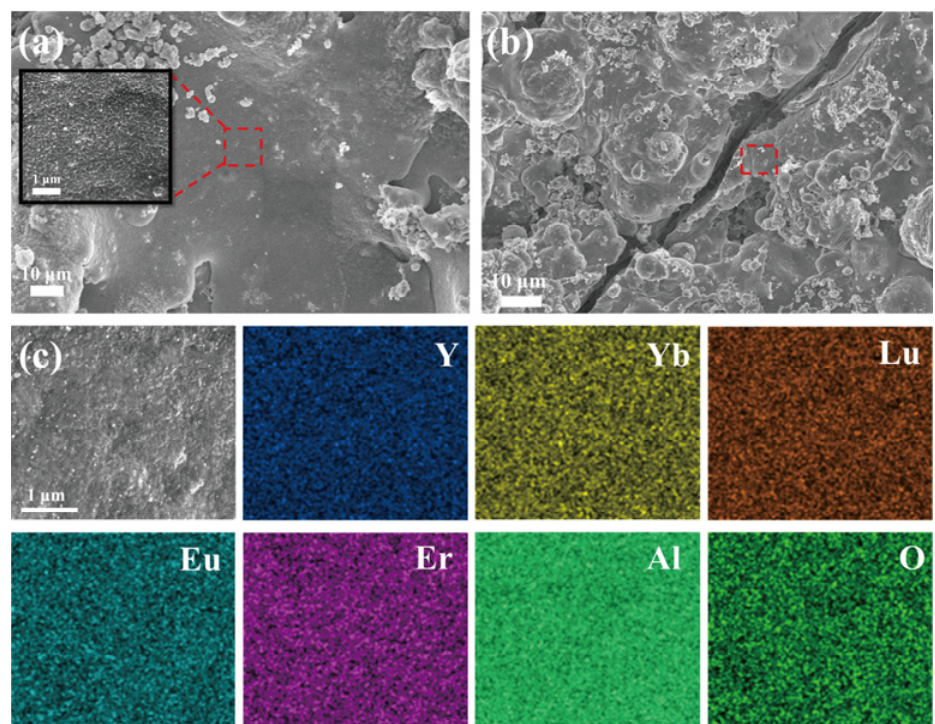
Fig. 9 Surface morphologies of the HE-RE 3 Al 5 O 12 coatings after the thermal shock tests: (a) at 1200 ℃ after 50 thermal shock cycles; (b) at 1400 ℃ after 10 thermal shock cycles. (c) EDS elemental mappings on the surface of the HE-RE 3 Al 5 O 12 coating (selected next to crack in